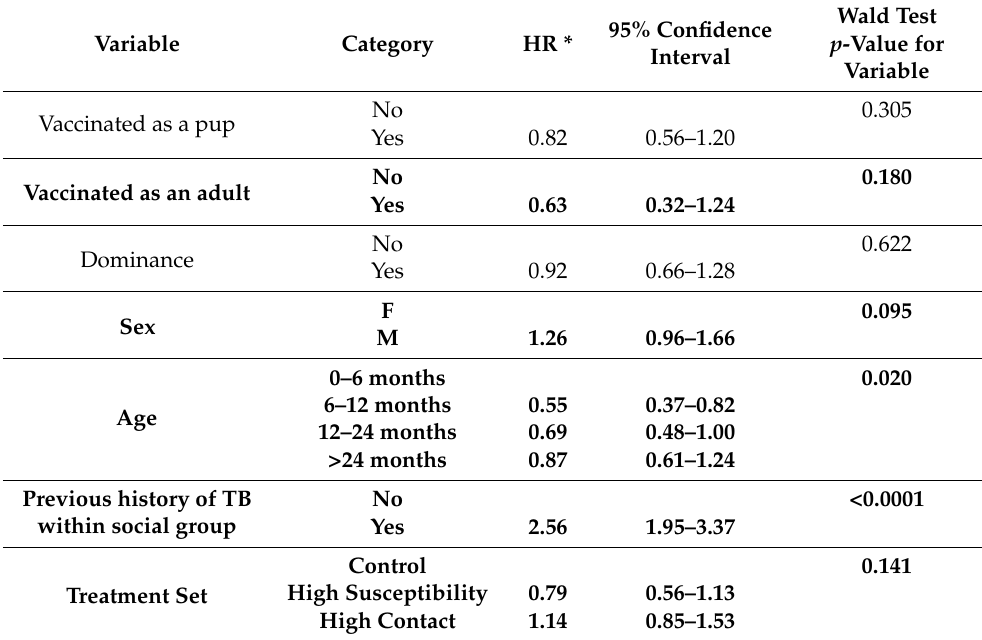
Table 2. Univariable analysis for survival time to death in 306 wild meerkats.